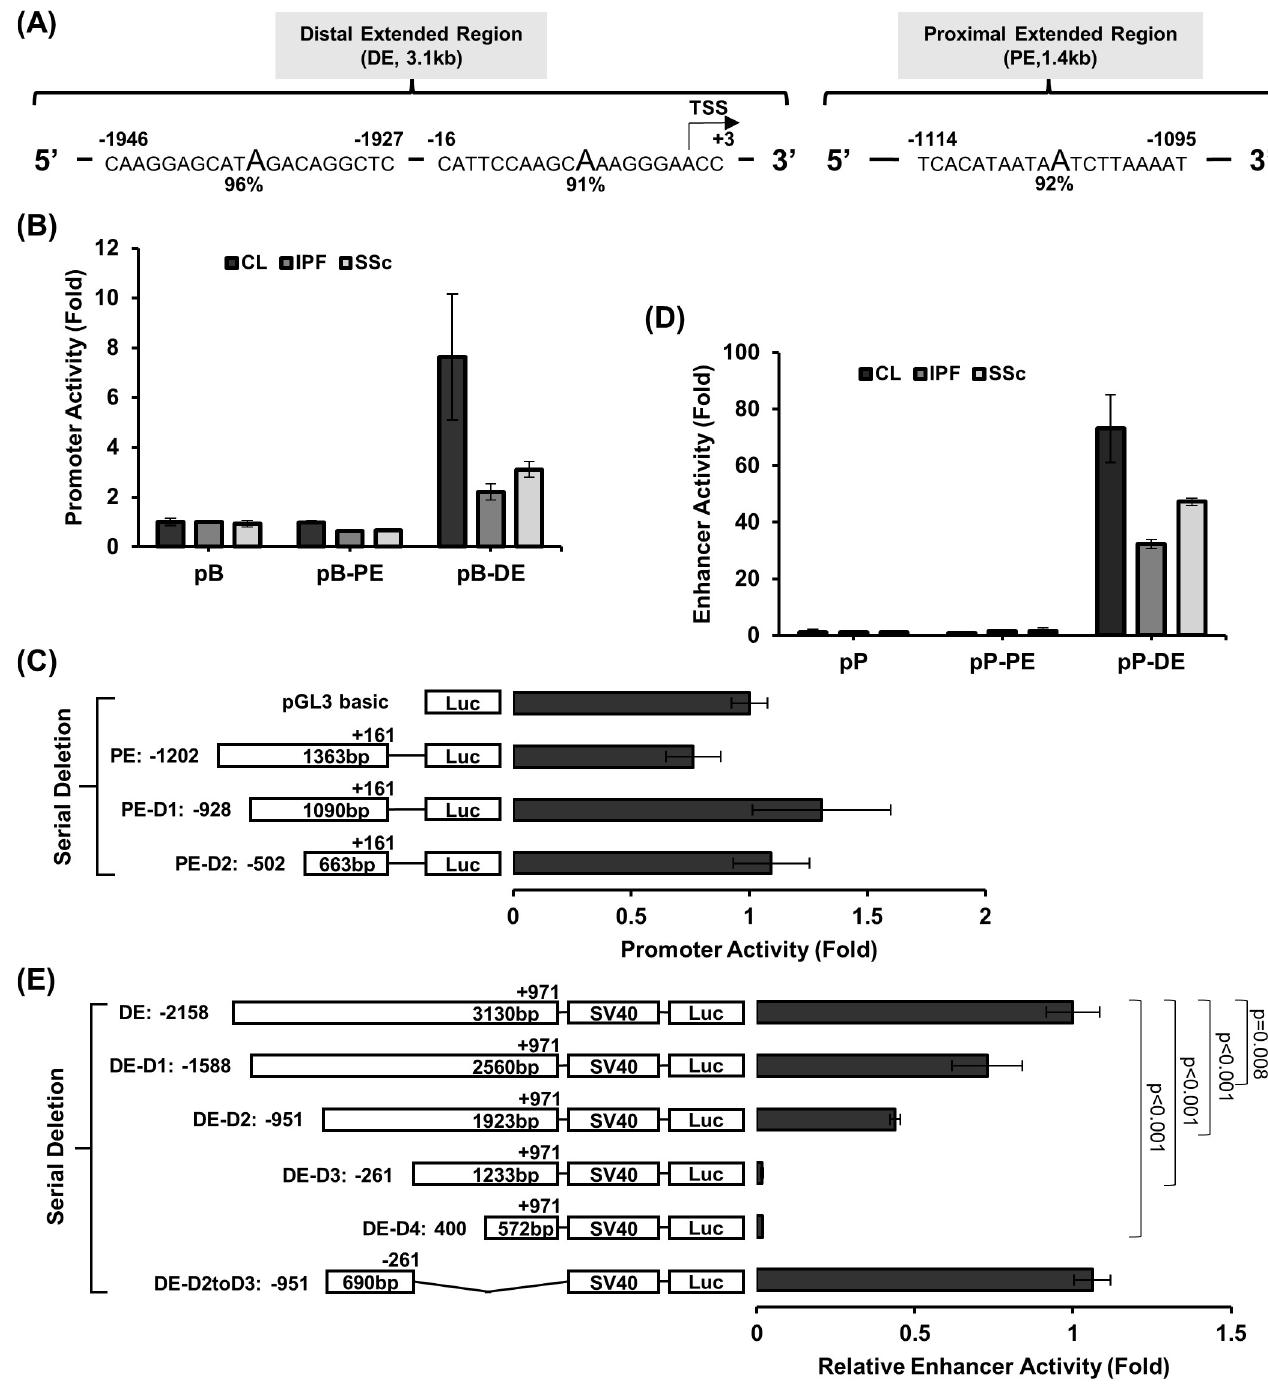
Fig 2. The promoter and enhancer activity in the extended proximal and distal regulatory regions. (A) Locations of TATA elements identified in the extended 3.1kb distal (DE) and 1.4kb proximal (PE) regulatory regions are shown using the Neural Network Promoter Prediction method (http://www.fruitfly. org/seq_tools/promoter.html). Relative nucleotide locations to the TSS are labelled. (B) Promoter activities of the extended proximal (pB-PE) and distal (pB-DE) regulatory regions with pGL3 promoter reporter system (transfections performed in duplicates) using control (CL), idiopathic pulmonary fibrosis (IPF) and systemic sclerosis (SSc) lung fibroblasts are shown. The transfection was performed in duplicates and fold changes relative to the pGL3basic (PB) vector are shown. Four control, 2 IPF, and 2 SSc independent lung fibroblast lines were tested and results from a representative experiment are shown as mean ± standard deviation. (C) Deletional analyses of the extended proximal regulatory region (PE-D1, proximal deletion 1; PE-D2, proximal deletion 2) using control fibroblasts. The transfection was performed in triplicates and tested in 1 control and 3 IPF independent lung fibroblast lines and results from a